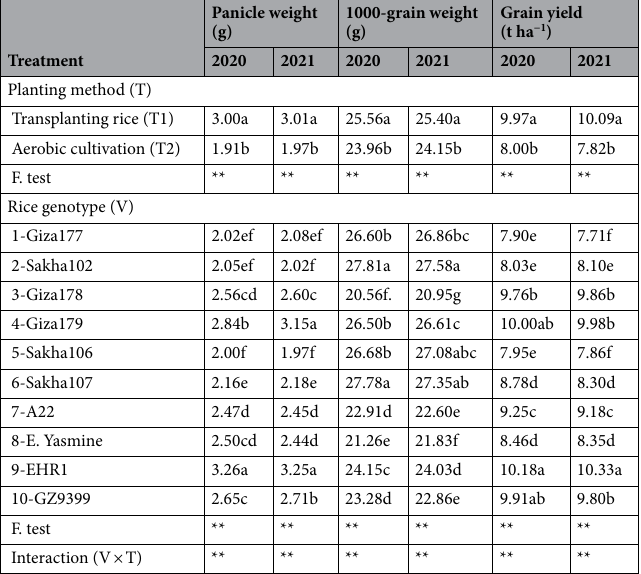
Table 15. Panicle traits and grain yield of some rice affected by the planting methods and rice genotypes. **Significant at 0.01 level. Means followed by a common letter at the same column are not significantly different according to Duncan ’ s multiple range at 0.05